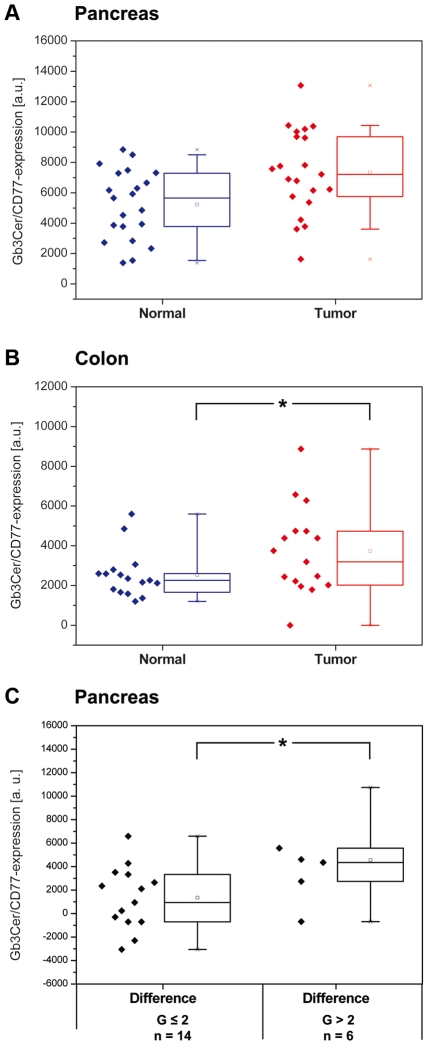
Box plots of Gb3Cer/CD77 expression in pancreas (A) and colon (B) normal and tumor tissues.The boxes are bounded above and below by the 25% and 75% percentiles. The lines in the boxes and the little squares indicate the median and mean values and the two×the minimum and maximum values, respectively. A, although not significant (P = 0.189, n = 21), an enhanced expression of Gb3Cer/CD77 could be observed in pancreatic tumors compared to normal tissues. B, the expression of Gb3Cer/CD77 is markedly increased in tumor colon tissues compared to that in the adjacent normal tissues indicating an association between Gb3Cer/CD77 expression and neoplastic transformation (*, P = 0.021, n = 16). C, correlation between Gb3Cer/CD77 expression and pancreatic tumor differentiation (n = 20 patients, because one tumor could not be assigned; see Table 1). Tumors were divided into two groups according to histopathologic grading: grade≤2 (n = 14 patients) and grade>2 (n = 6 patients). Rank correlation analysis of difference values points to a statistically significant higher Gb3Cer/CD77 expression in pancreas tumors graded as>2 (*, P = 0.039, τ = 0.396).